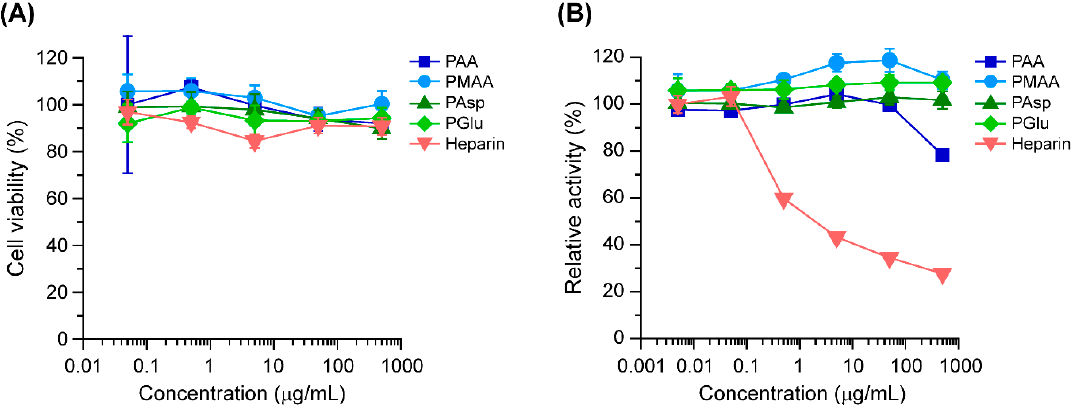
Figure 4. ( A ) Relative viability of MC3T3-E1 cells treated with polycarboxylates and heparin at various concentrations for 24 h (n = 6). ( B ) Relative enzymatic activity of Factor Xa after incubation with a mixture of antithrombin III and polycarboxylates or heparin at various polymer concentrations (n = 3). The plots represent PAA (squares), PMAA (circles), PAsp (triangle), PGlu (diamonds), and heparin (down triangles). The data are expressed as the mean ± standard deviation (SD).